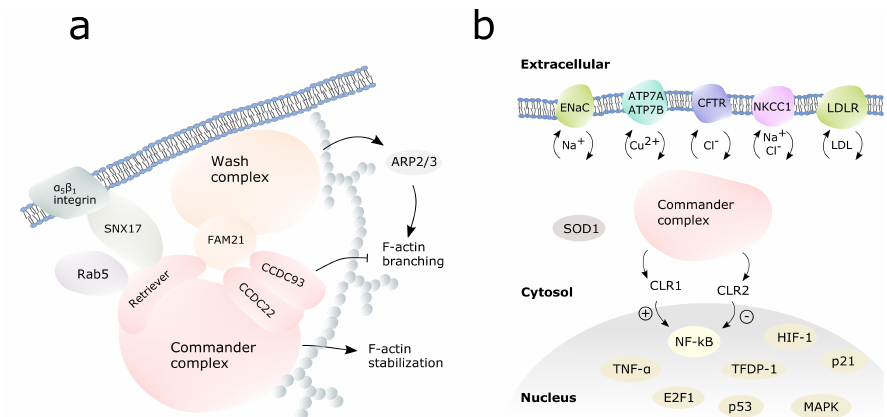
Figure 3. Commander complex in cargo and cell signaling. ( a ) Assembly of the commander-WASH complex for the endosomal cargo. The WASH complex is shown in orange, the commander complex in pink. White spheres represent F-actin. ( b ) The commander complex (pink) regulates the cargo of transmembrane channels to the cell surface and back, as well as the activity of selected transcription factors in the